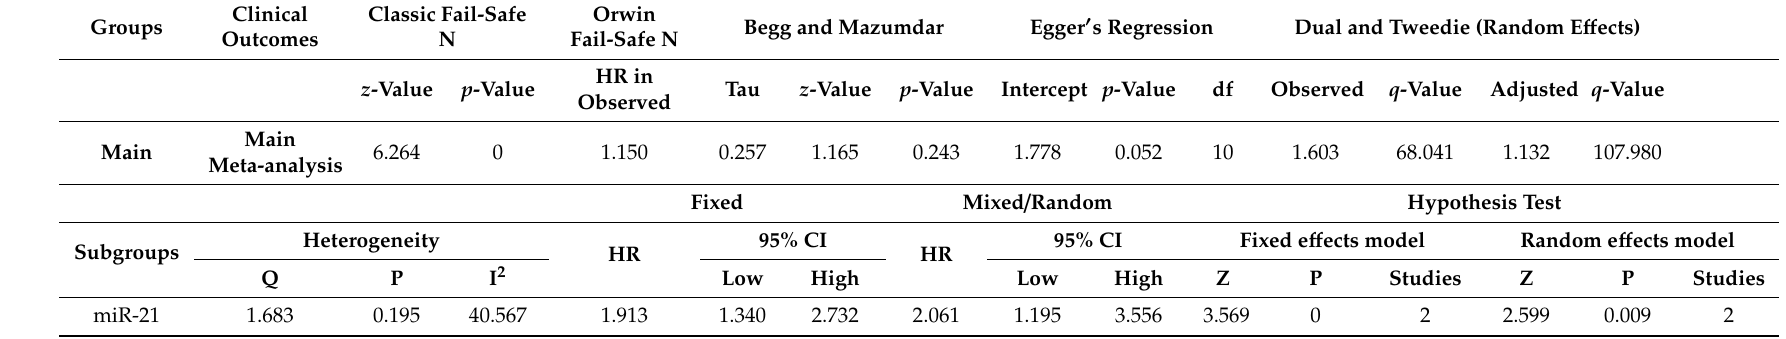
Table 4. Publication bias of the included